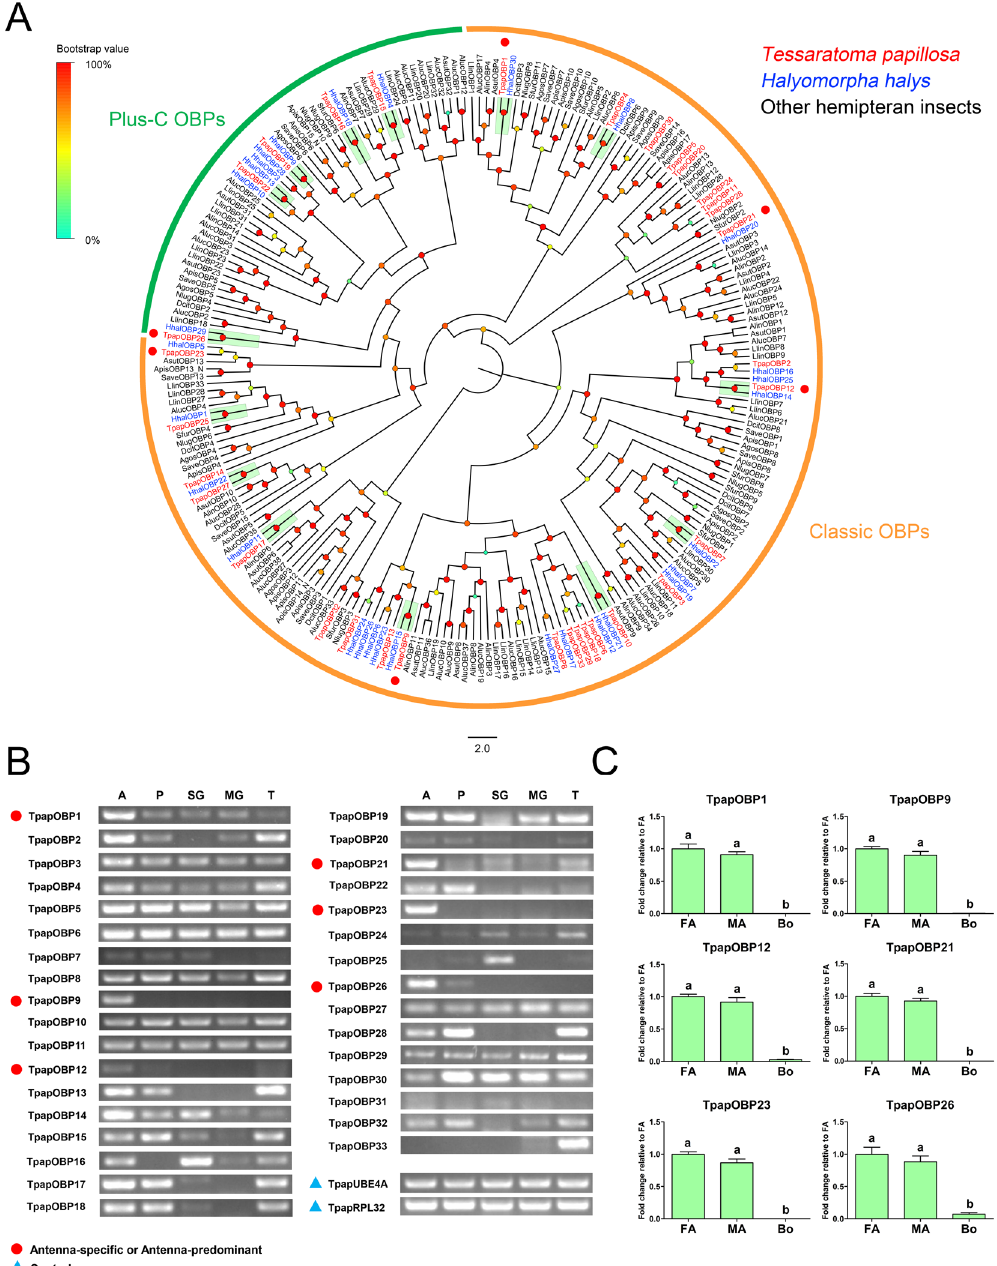
Figure 6. ( A ) Phylogenetic analysis of putative T . papillosa OBPs with other hemipteran OBPs. Plus-C OBPs from T . papillosa and other putative hemipterans form a clade labeled in dark green. Labeled in orange are classic OBPs from T . papillosa and other putative hemipterans. Species abbreviations: Tpap, Tessaratoma papillosa ; Hhal, Halyomorpha halys ; Llin, Lygus lineolaris ; Aluc, Apolygus lucorum . Alin, Adelphocoris lineolatus , Asut, Adelphocoris suturalis , Save, Sitobion avenae , Apis, Acyrthosiphon pisum , Agos, Aphis gossypii , Nlug, Nilaparvata lugens , Sfur, Sogatella furcifera , Dcit, Diaphorina citri . Amino acid sequences used to construct the tree are shown in Supplementary Table S2. ( B ) Transcriptional profiles of putative T . papillosa OBPs in different body parts determined by semi-quantitative RT-PCR. The OBPs that are upregulated in the antennae are labeled with red dots. Two reference genes labeled with blue triangle, ubiquitin conjugation factor E4 A (TpapUBE4A) and 60 S ribosomal protein L32 (TpapRPL32), were used as internal references to test the integrity of each cDNA templates. Abbreviations: A: antenna; P, proboscis; SG, stink gland; MG, midgut; T, tarsus. ( C ) Relative expression levels of antenna-predominant OBPs in the female and male antennae, and other body parts. Abbreviations: FA, female antennae; MA, female antennae; Bo, other body parts. Expression levels were estimated using the 2 −ΔΔ CT method. The relative expression level is indicated as mean ± SE (n = 4). Standard error is represented by the error bar, and different letters indicate statistically significant difference between tissues (p < 0.05, ANOVA,